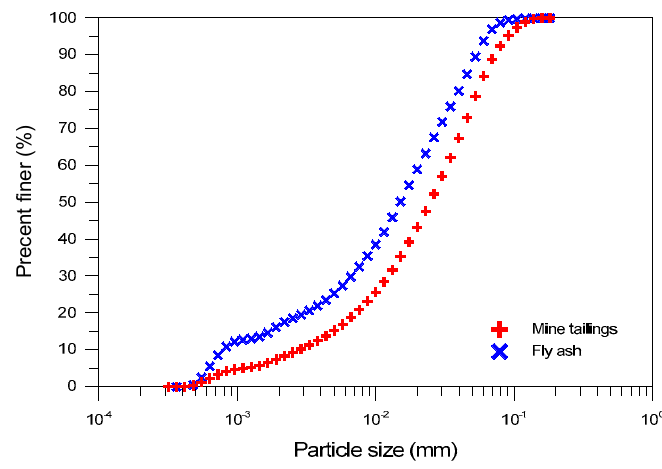
Figure 2. Particle size distributions of materials tested.